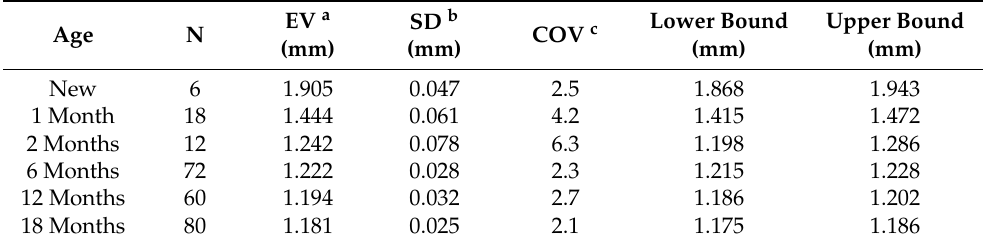
Table 6. Expected value and standard deviation of overall MPD by